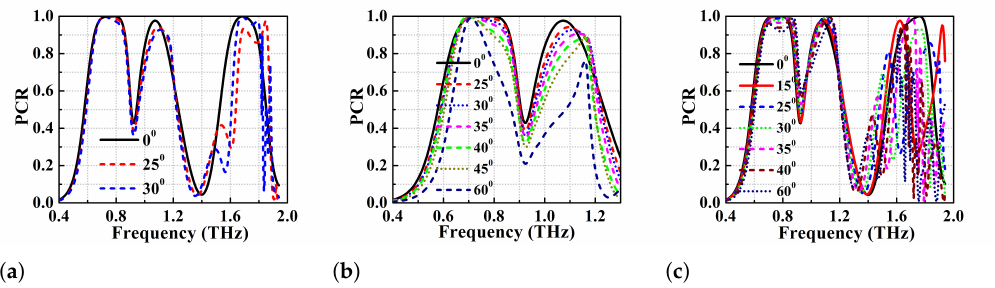
Figure 15. Angular stability analysis of the triple band PC ( a ) PCR for TE mode ( b ) PCR for TE mode in 1st and 2nd band ( c ) PCR for TM